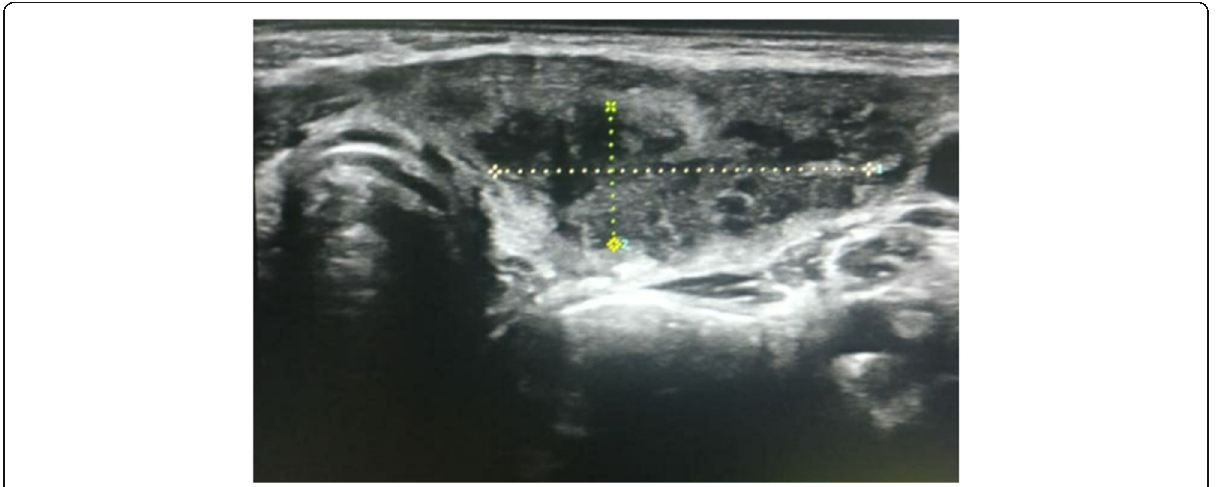
Fig. 2 Ultrasonography of neck suggestive of intercommunicating pockets of collections with internal echoes in left thyroid lobe (demarcated dotted